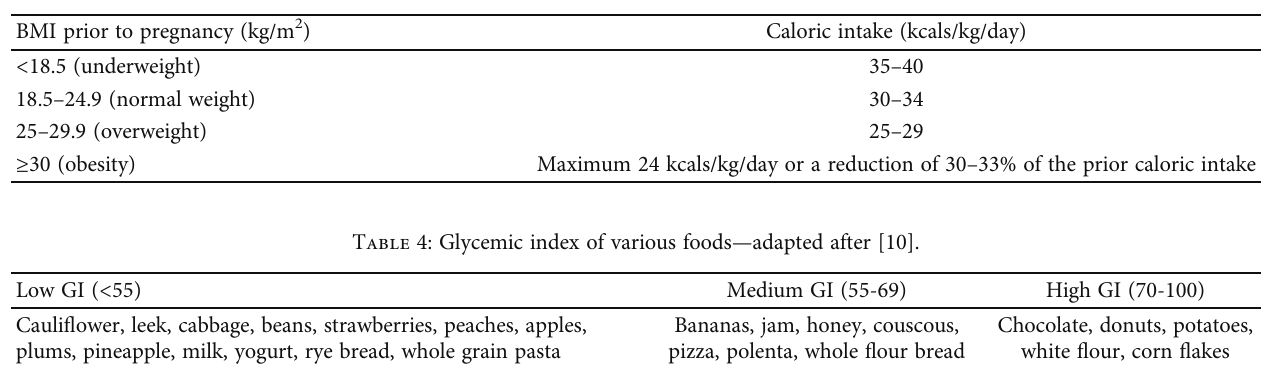
Table 3: The caloric intake of pregnant women with GDM according to DDG-DGGG (German Diabetes Association and German Association for Gynaecology and Obstetrics) [23].